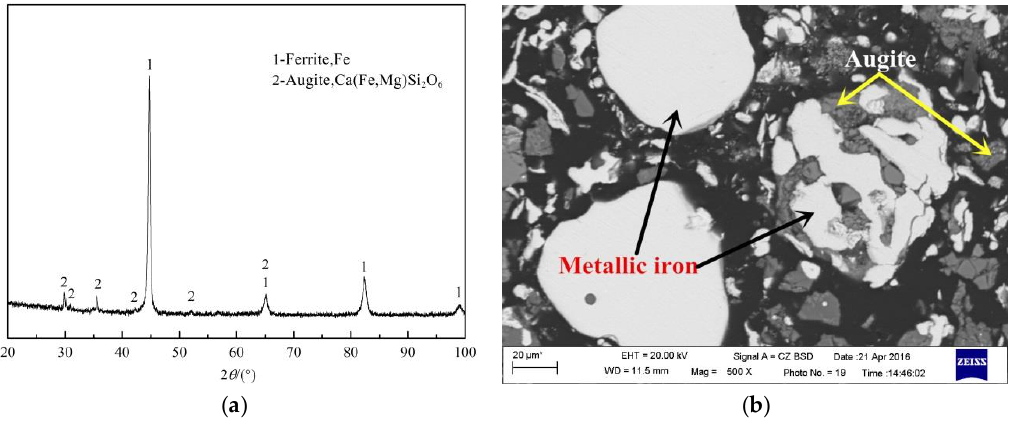
Figure 10. XRD patterns ( a ) and SEM image ( b ) of the iron powder from the grinding/magnetic separation.